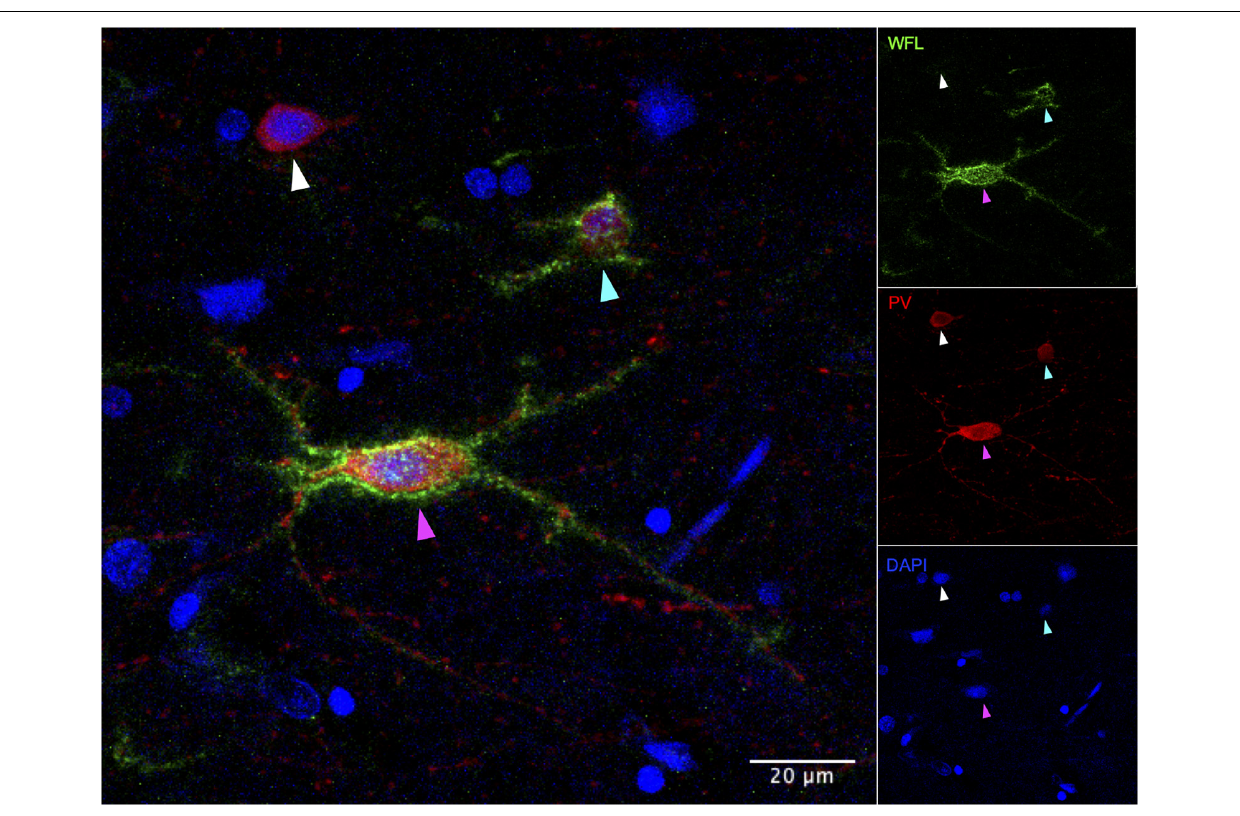
Frontiers in Human Neuroscience |